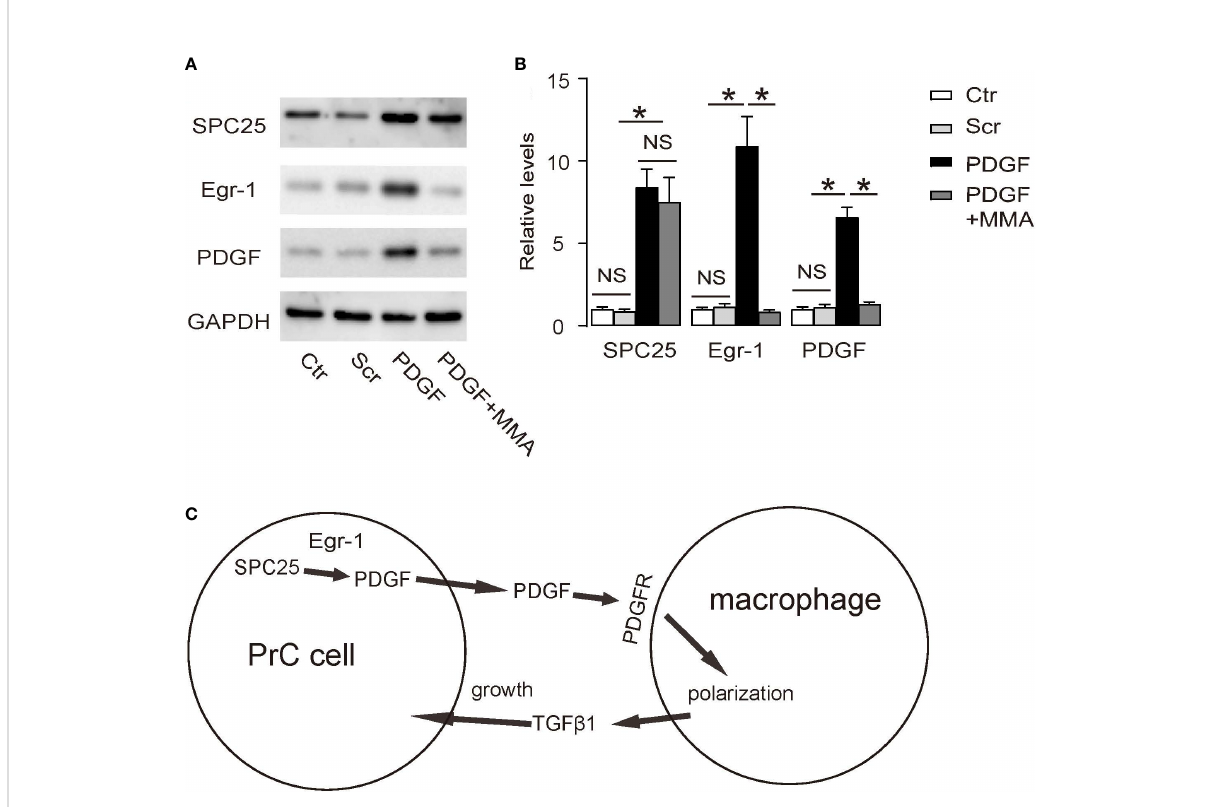
FIGURE 6 SPC25 activates PDGF through Egr-1 (A, B) Mithramycin A (MMA) was added at a dose of 0.1 µg/ml into the cultured LNCap cells. (A) Representative Western blots of SPC25, Egr-1, and PDGF, and (B) corresponding quanti fi cation. (C) A schematic of the model in this research: SPC25 in PrC cells enhances PDGF production likely through Egr-1 to polarize macrophages towards TAM through their surface expression of PDGFR. Polarized macrophages (TAM) produce TGF b 1 to promote growth of PrC cells. * p < 0.05. NS, non-signi fi cant. n =